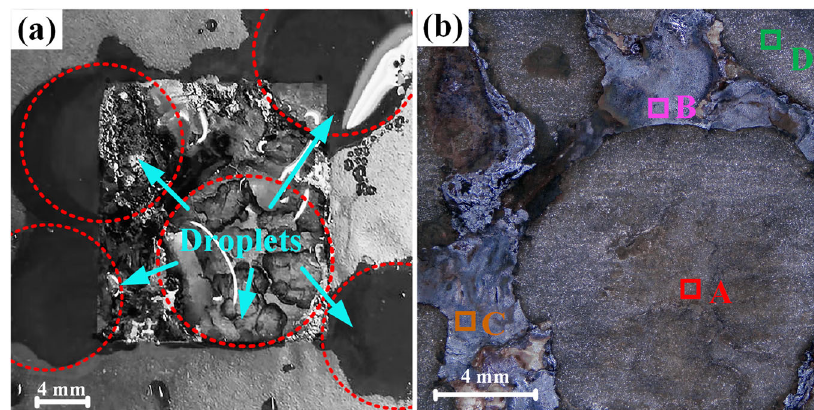
Fig. 5 The photos of the steel coupon. a After 7 days of TLC test. b After being